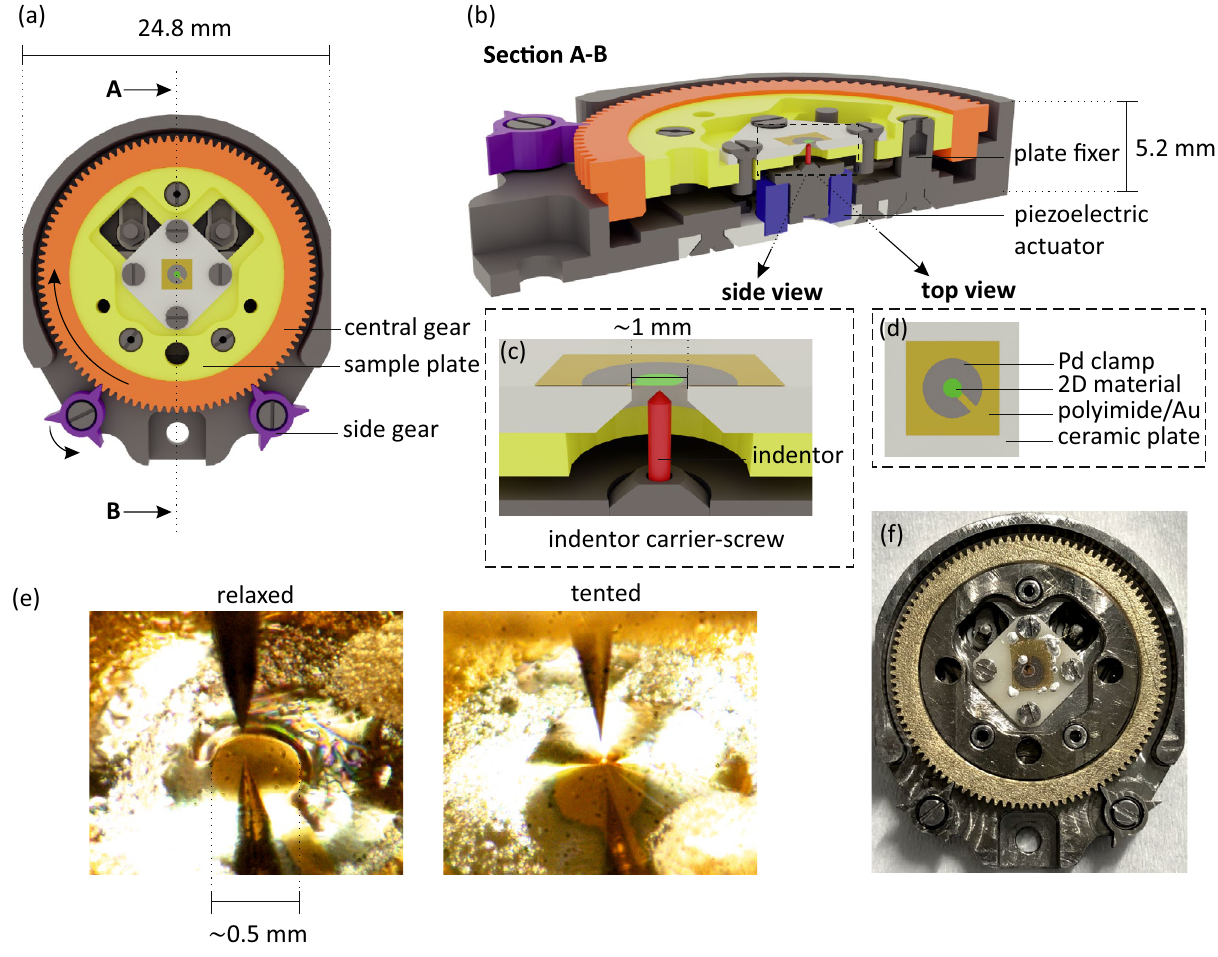
Figure 2. Design of strain- and gate-controllable STM sample holder. ( a ) 3D model top view. ( b ) Cross section of A-B line drawn in ( a ). ( c ) Detailed side view of the strained junction. ( d ) Top view of the sample area. ( e ) Optical images of STM tunneling junction where the strain conditions of sample are controlled using gearbox system. ( f ) Photograph of the sample